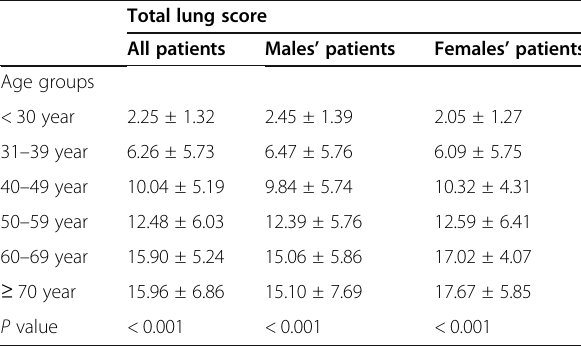
Table 4 Total lung score based on age group